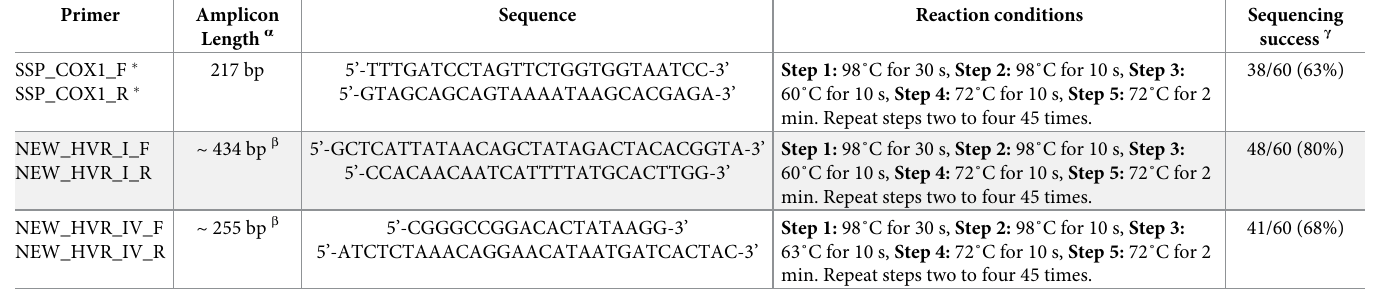
Table 1. PCR primers and reaction